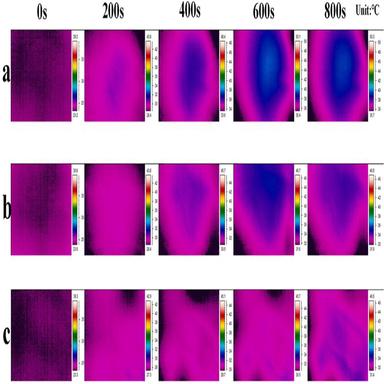
Infrared camera images of (a) Ref. EP, (b) MPCM/EP and (c) T-MPCM/EP during the heating process.